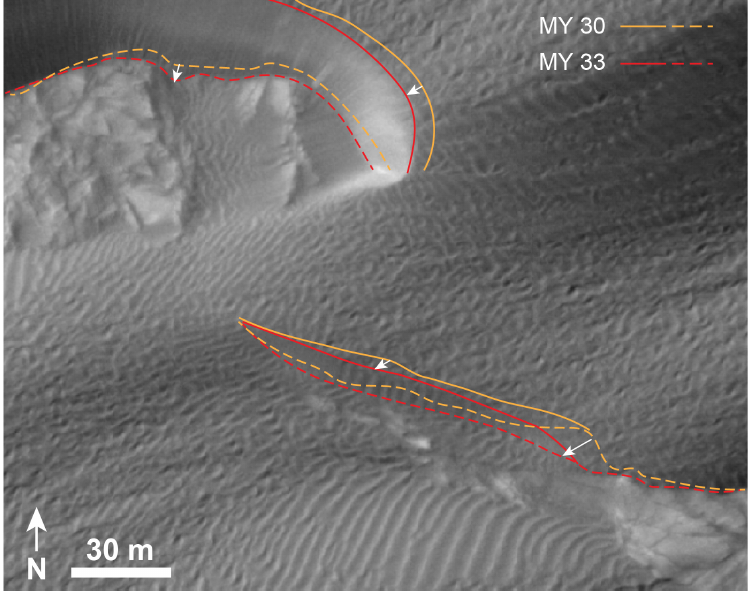
Figure 13. Dune migration in Nili Patera (8.70 ◦ N, 67.35 ◦ E) over three Mars years. The upper (solid lines) and lower (dashed lines) edges of stoss slopes traced on orthoimages ESP_017762_1890 (orange lines) and ESP_043779_1980 (red lines). For clarity, only the later image is shown (ESP_043779_1980). Small, white arrows indicate direction of bedform movement. See also Figure